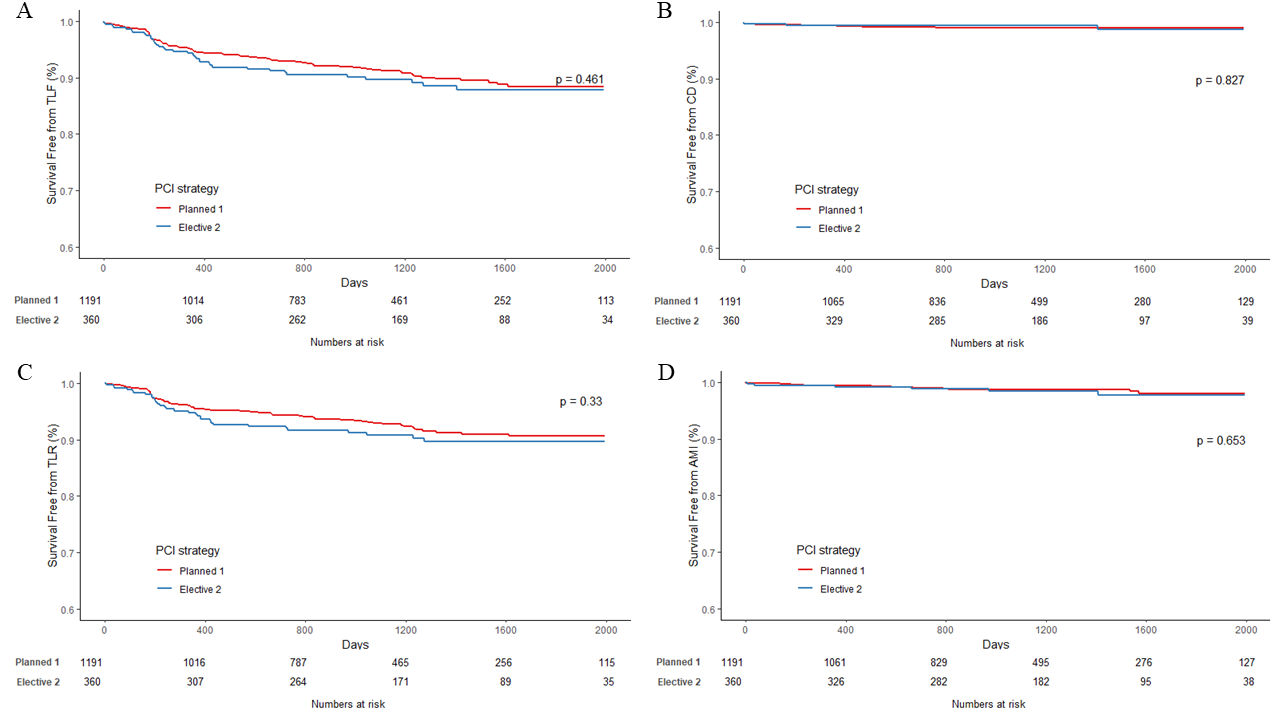
Figure 1. Kaplan–Meier curves in patients with LAD bifurcation lesions according to PCI strategies: planned one-stent (red) or elective two-stent (green). Curves are for ( A ) TLF, ( B ) cardiac death, ( C ) AMI, and ( D ) TLR, respectively. AMI = acute myocardial infarction; PCI = percutaneous coronary intervention; TLF = target lesion failure; TLR = target lesion